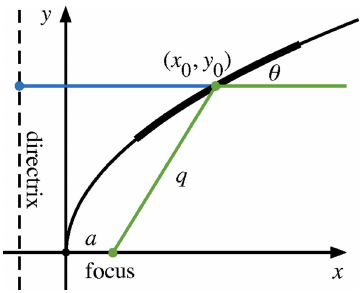
Figure 1 A section of a parabola showing the focus and the directrix line, and a ray reflected from the surface (green). The x -axis becomes the axis of rotation for a